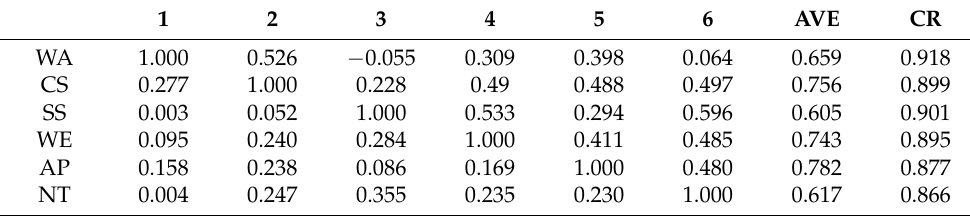
Table 3. Measurement model results ( n = 170).